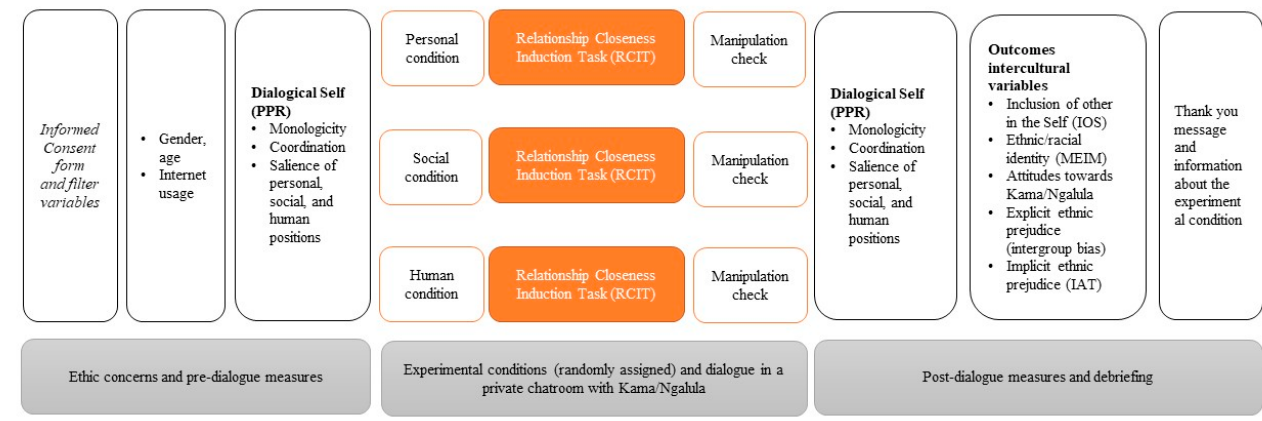
Figure 1. Design and measures used.